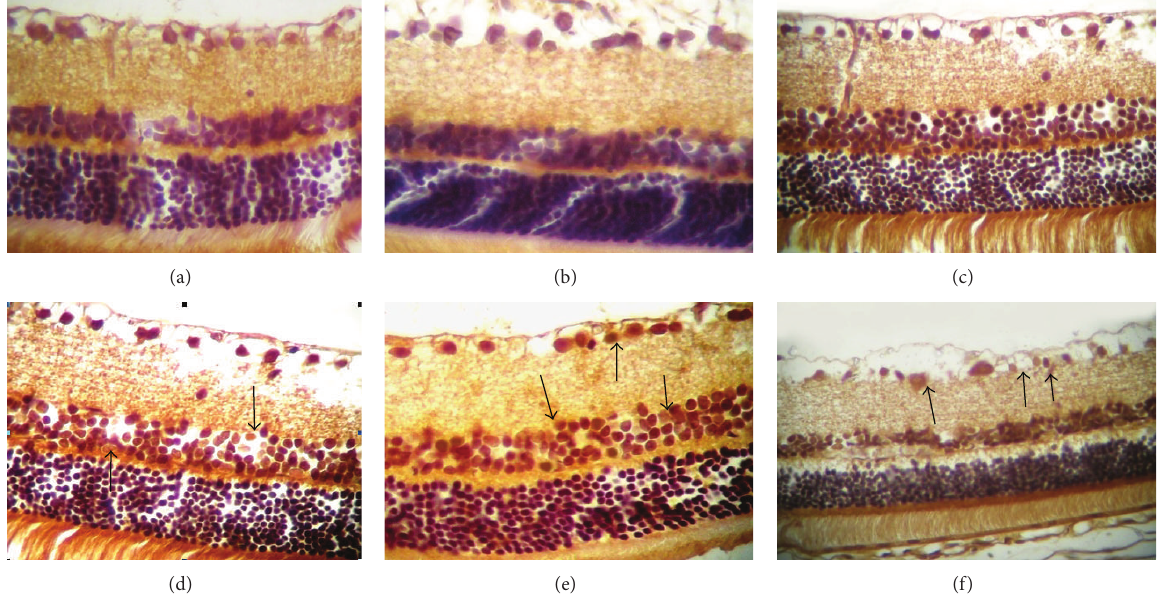
Figure 3: Microscopic detection of retina neuron apoptosis ( × 400). (a–c) Control group; (d–f) diabetic group. (Apoptosis is labeled with arrow.)